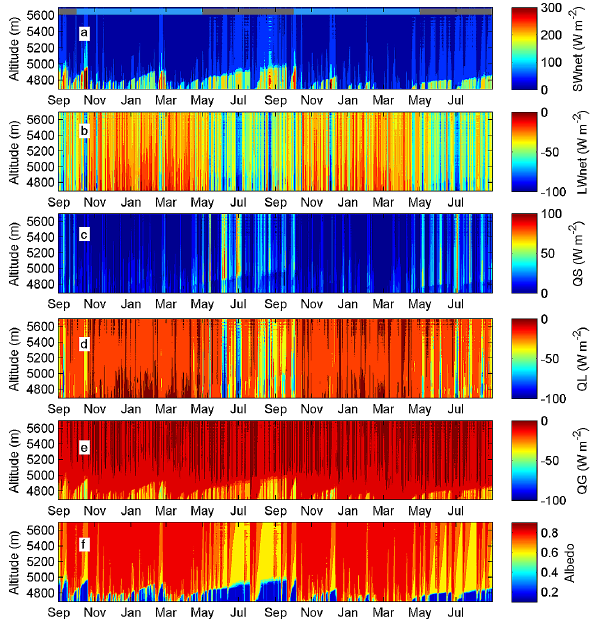
Fig. 9. Time series (September 2006–August 2008) of modeled en- ergy balance terms described in Sect. 2.2.1 (a–e) and of modeled surface albedo in (f) . All values are calculated as daily means for 10m steps in altitude. The grey and blue bars in (a) indicate the dry and wet season. Note the different value range in the color bar in (a) and (f) .